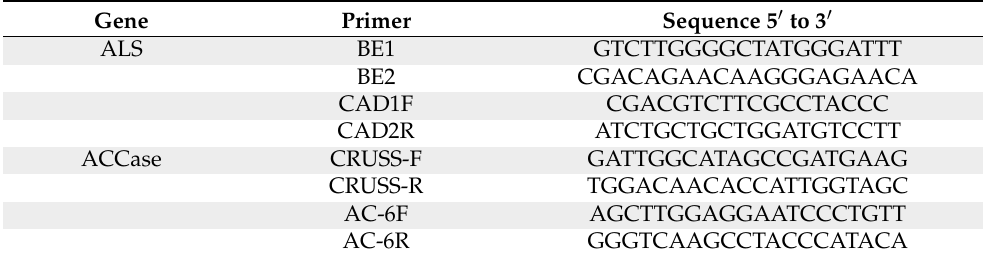
Table 2. Primers used for PCR amplification of ALS and ACCase gene. Gene